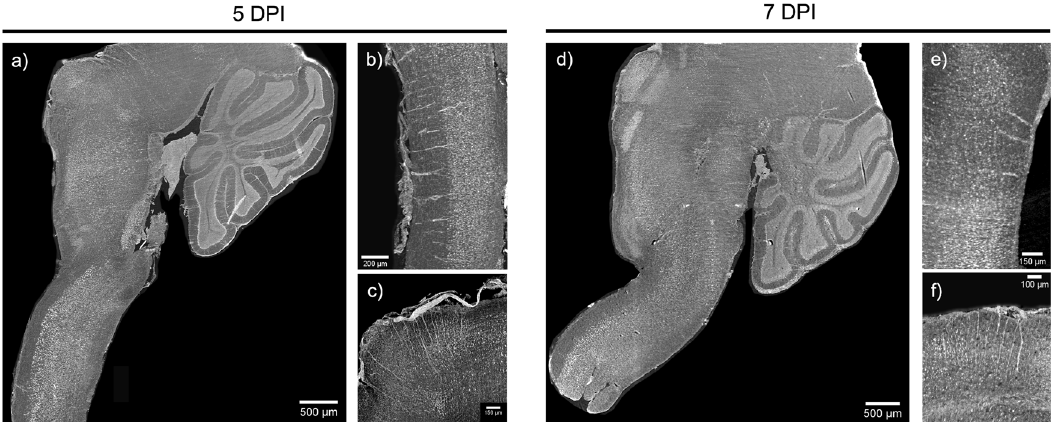
Fig. 4 Brain and cervical spinal cord at presymptomatic stages. X-ray phase contrast tomography (XPCT) images of brain and cervical spinal cord of 5 days post induction (dpi) and 7dpi EAE-induced mice. a Sagittal view of cerebellum, brain stem, and cervical spinal cord of a 5dpi EAE-induced mouse (scale bar = 500 μ m). b Coronal view of a portion of the cervical SC of a 5 EAE-induced mouse (scale bar = 200 μ m). c XPCT image of a detail of the brainstem at 5dpi (scale bar = 150 μ m). d Sagittal view of cerebellum, brain stem, and cervical SC of a 7dpi EAE-induced mouse (scale bar = 500 μ m). b Coronal view of a portion of the cervical SC of a 7dpi EAE-induced mouse (scale bar = 150 μ m). c XPCT image of a detail of the brainstem at 7dpi (scale bar = 100 μ m). Images were obtained as maximum intensity projections of XPCT volumes ( a over 130 μ m; b over 100 μ m; c over 80 μ m; d over 150 μ m; e over 80 μ m; f over 80 μ